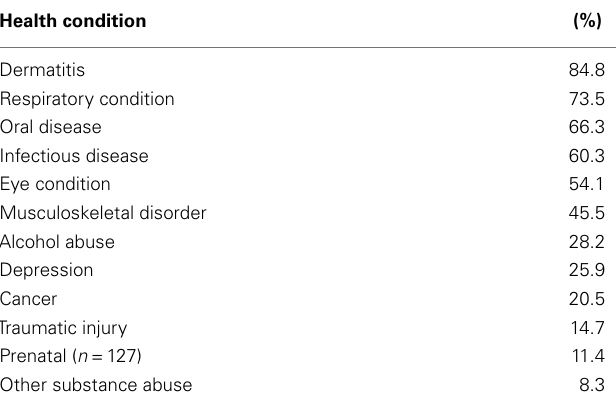
Table 2 | Self-reported health problems in the last 12months